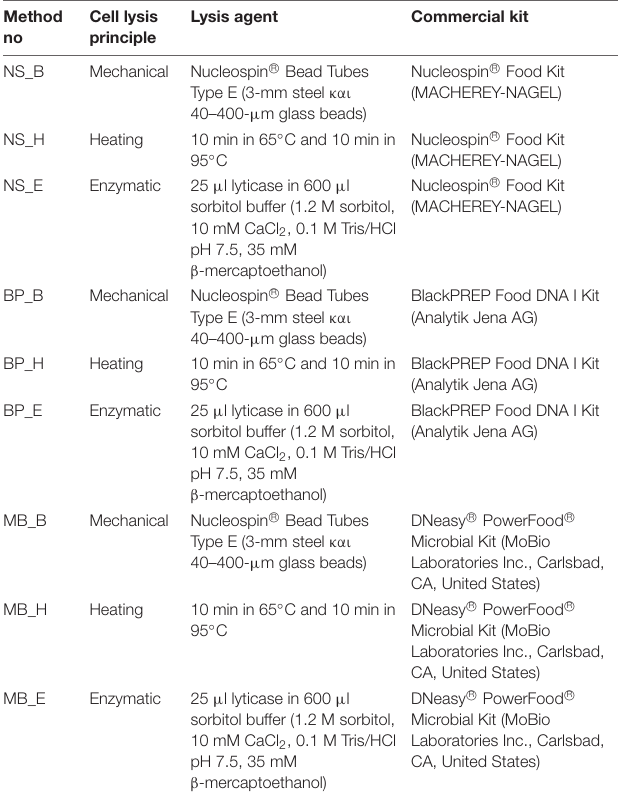
TABLE 2 | The three different cell lysis principles that were applied to the three commercial DNA extraction